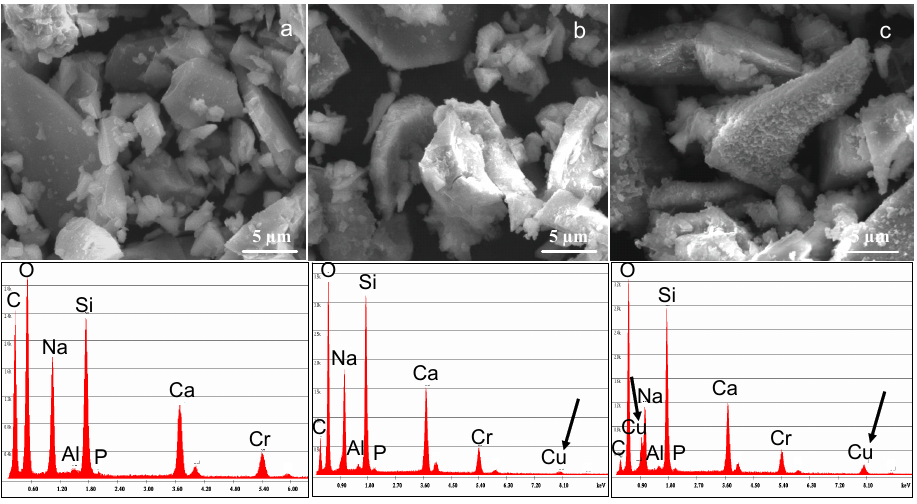
Figure 7. SEM-EDS analyses of ( a ) SBA3; ( b ) SBA3-Cu0.01; and ( c ) SBA3-Cu0.05. Table 3. EDS analysis: atomic percentages of SBA3, SBA3-Cu0.01, and SBA3-Cu0.05.